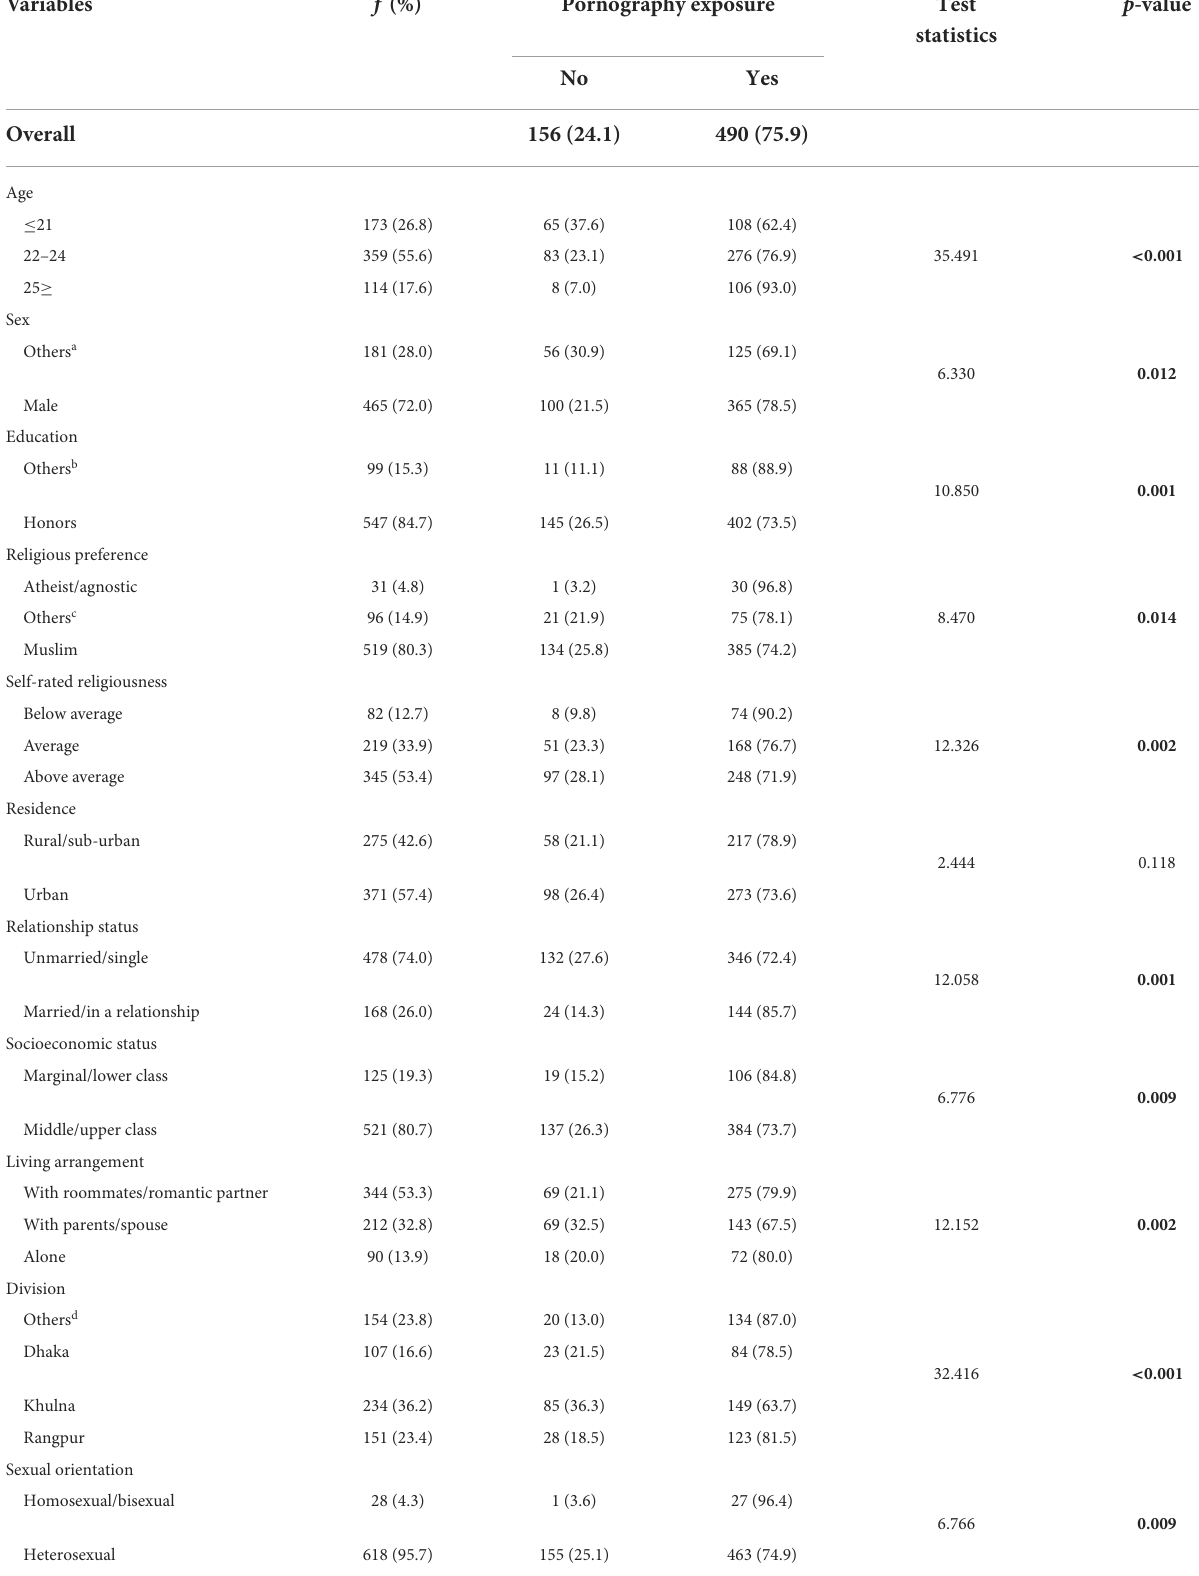
TABLE 1 Basic characteristics of participants and their association with pornography